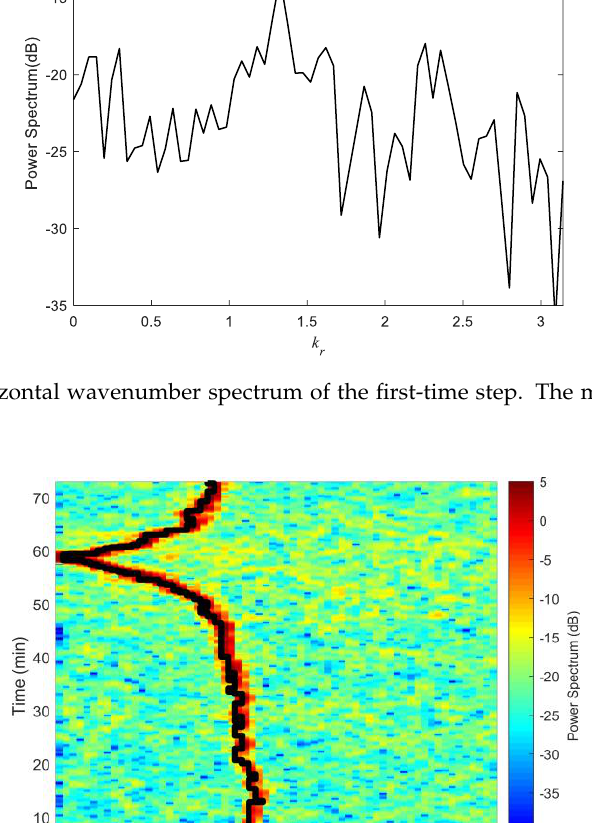
Figure 12. Estimated radial velocity from Figure 11 and best fit to the model given in Equation (1). The source range is estimated and shown in Figure 13. It can be seen that the estimated source ranges are in good agreement with the ranges from GPS data, and exhibit a bias of 6.23%.